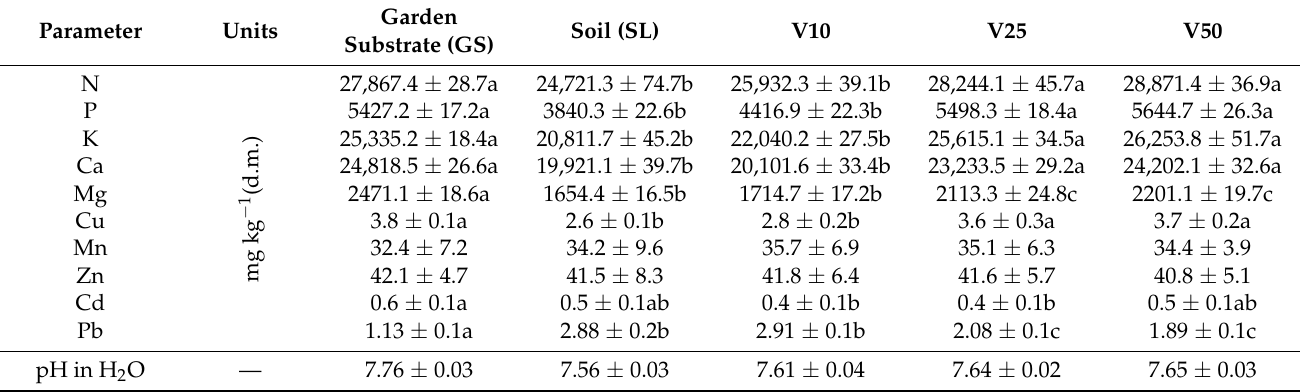
Table 3. Contents of macro and microelements in biomass of P. sativum stalks (mean ± standard deviation based on five replicates).